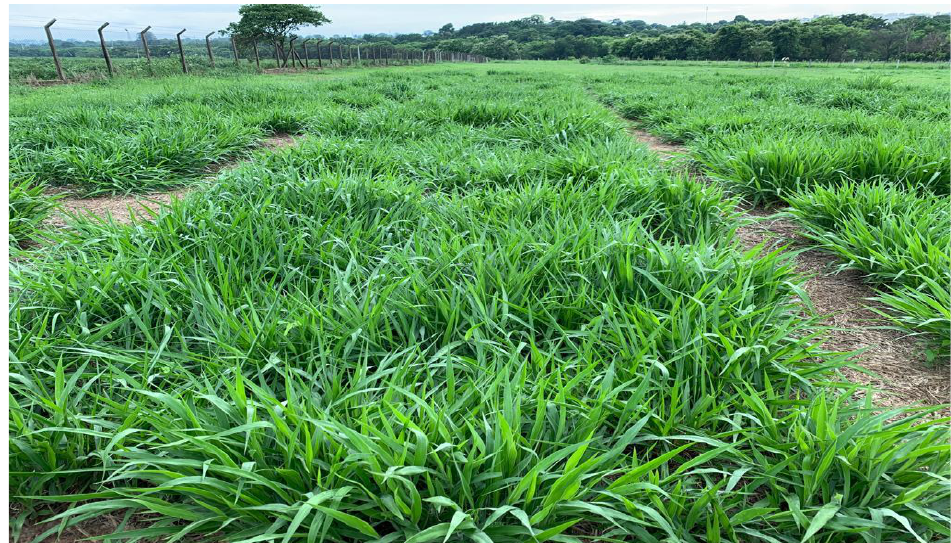
Figure 2. Cutting day in the summer season.